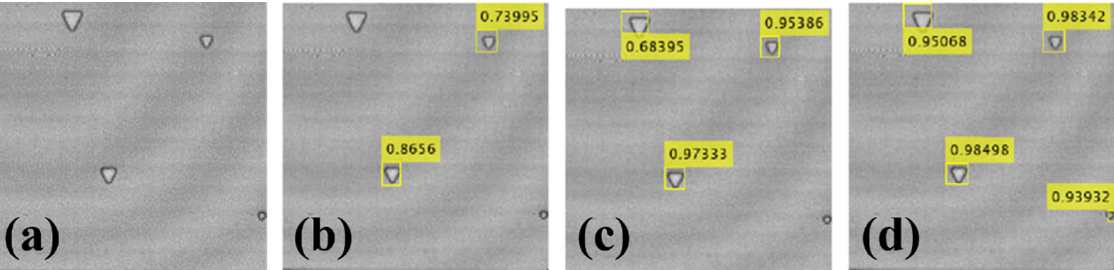
Figure 11. Comparison of defect detection performance of the validation set: ( a ) original, ( b ) fast R-CNN, ( c ) faster R-CNN, and ( d ) improved faster R-CNN.